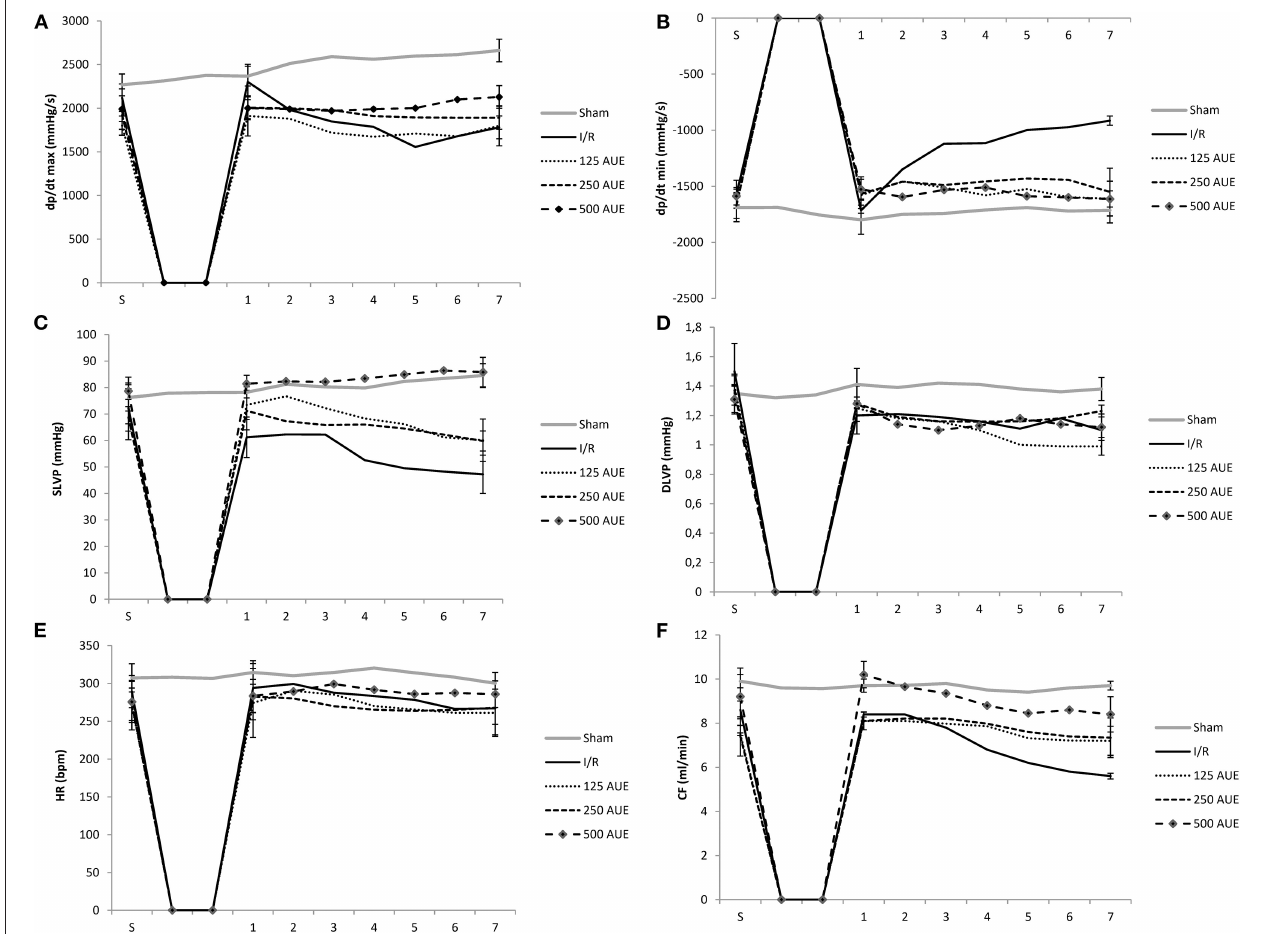
FIGURE 1 | Effects of consumption of increasing doses of Allium ursinum methanol extract (AUE) on the value of maximum rate of pressure development in the left ventricle (dp/dt max) (A) , minimum rate of pressure development in the left ventricle (dp/dt min) ( B ), systolic left ventricular pressure (SLVP) (C) , diastolic left ventricular pressure (DLVP) (D) , heart rate (HR) (E) , coronary flow (CF) (F) ( n = 50, 10 animals per group). Values are shown as mean ±